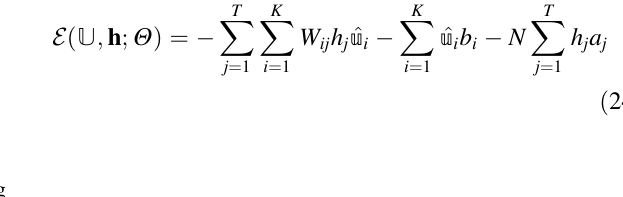
Fig. 3 Graphical interpretation of RSM ( a ) without weight sharing ( b ) with weight sharing